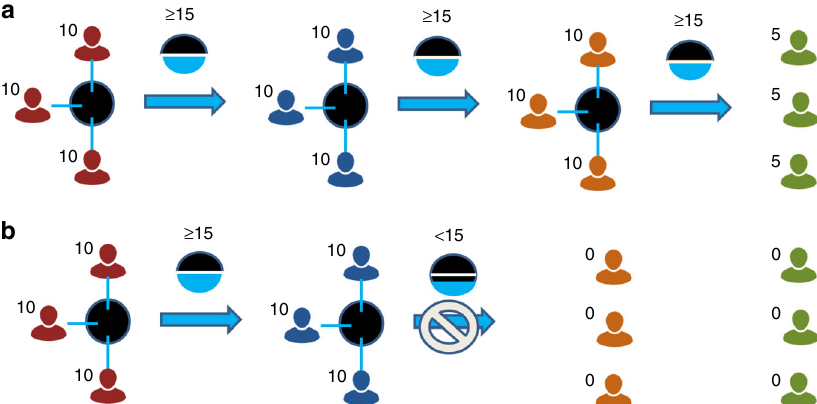
Fig. 1 The experimental design. Each member of the fi rst group is endowed with € 10 and all three members make simultaneous contributions to the group account. a A case where total contributions to the group account by each group are suf fi cient for the game to continue. In this case, members of group 2 are also endowed with € 10 each, and can likewise decide about their contributions to a group account. This process is the same for group 3. If contributions of group 3 reach the threshold, each member of group 4 receives an endowment of € 5 and the game ends without any further decision being made. b A case where contributions of group 2 fail to reach the threshold. Hence, the game stops after each member of this group has made a decision, and members of the subsequent groups 3 and 4 are endowed with